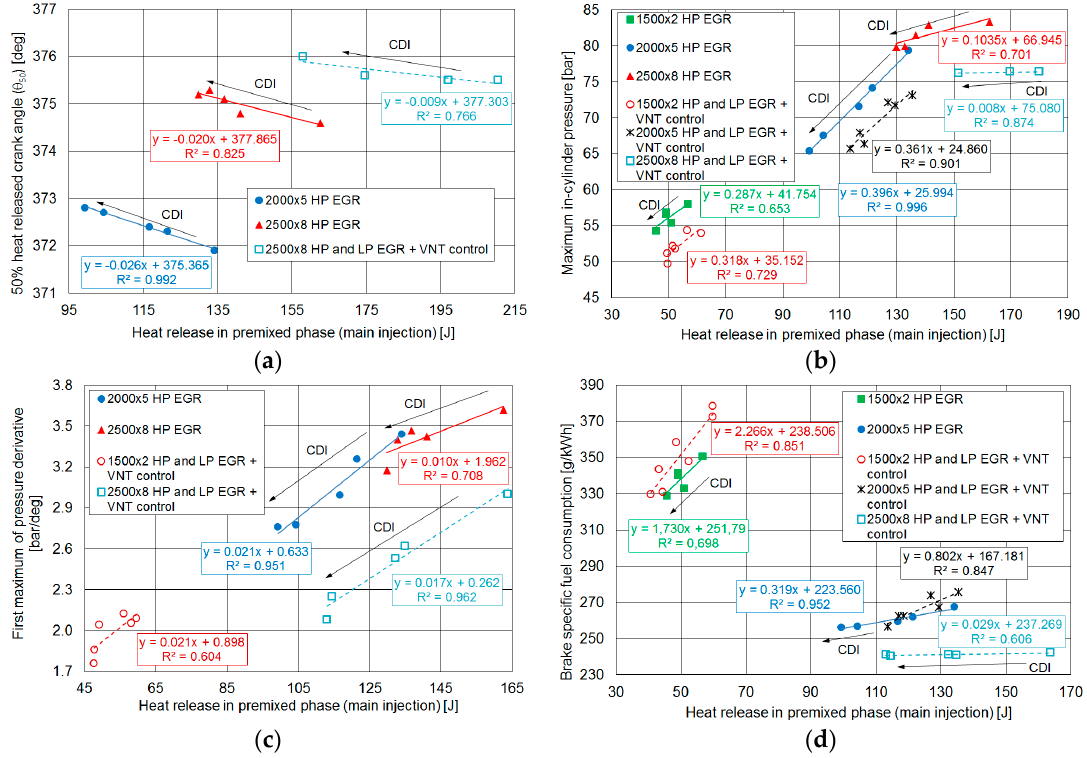
Figure 9. Link between heat released in premixed phase and θ 50 ( a ), p MAX ( b ), dp MAX 1 / d θ ( c ) and bsfc ( d ) in different test sets.